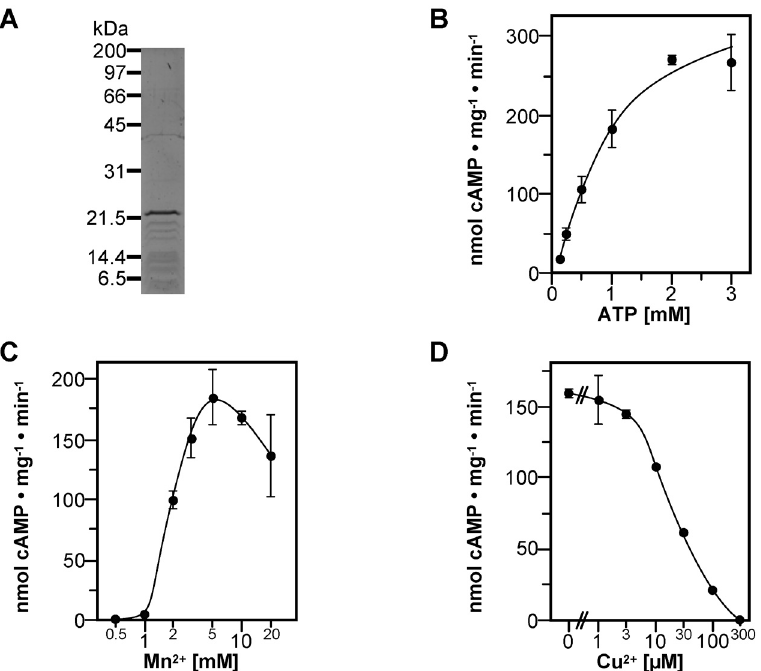
Fig 2. Biochemical analysis of the catalytic domain MpAC 1-182 . (A) SDS-PAGE of MpAC 1-182 . (B) Substrate kinetics measured with 5 mM Mn 2+ as a cofactor at 30°C and pH 8.0. Vertical bars indicate the standard deviation if larger than symbol size. (C) Mn 2+ -dependance assayed at 1 mM ATP. (D) Inhibition by Cu 2+ . Reactions contained 1.6 μ M MpAC 1-182 , 5 mM Mn 2+ and 1 mM ATP.